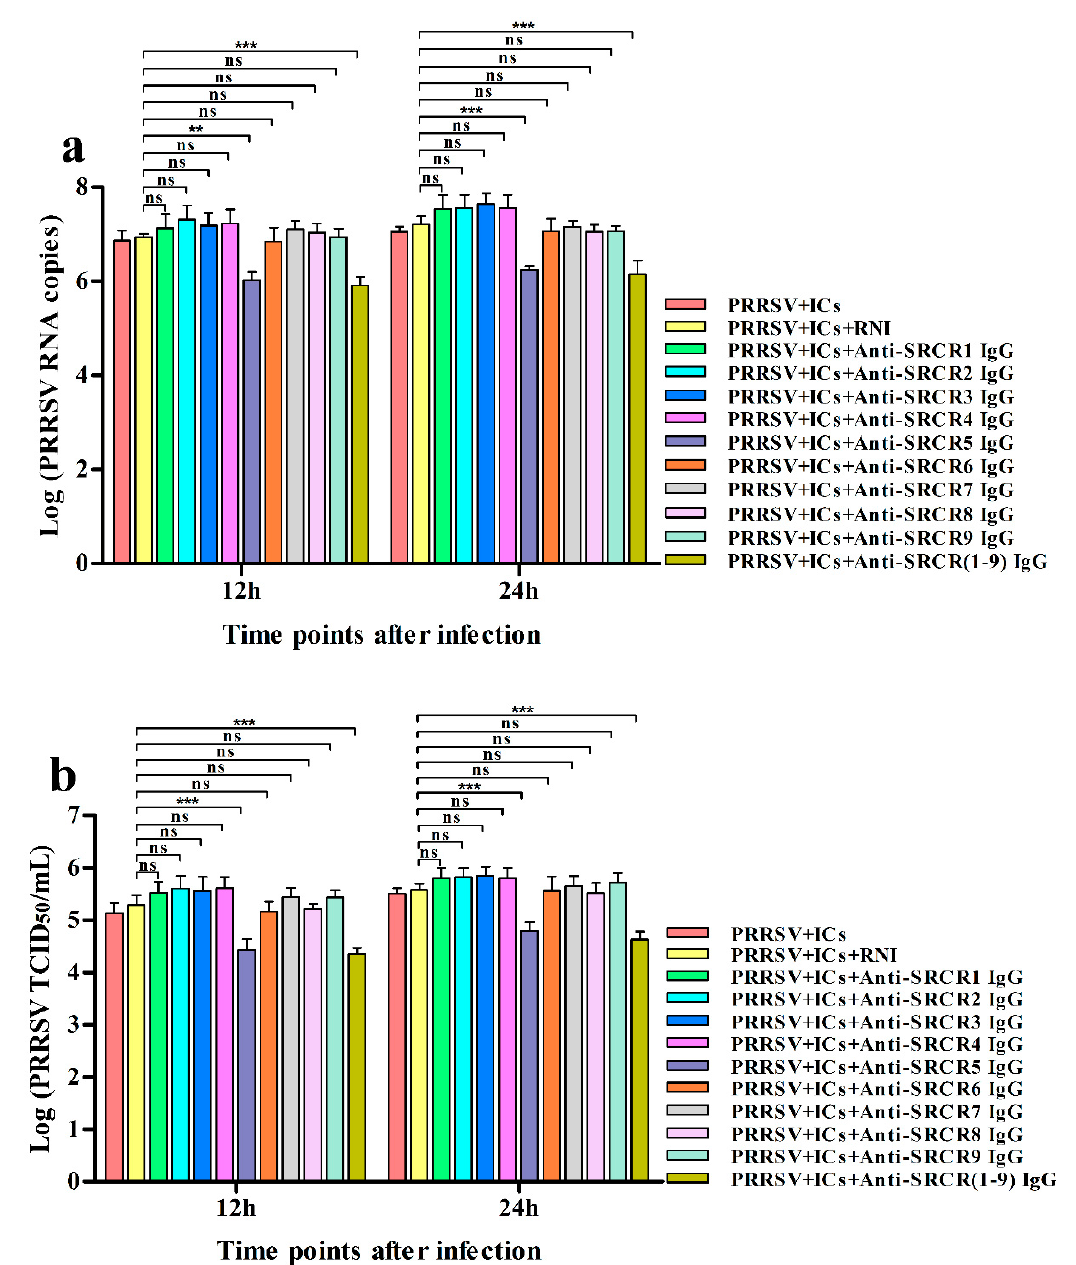
Figure 7. Effect of the antibody blocking of CD163 SRCR domains on PRRSV-ADE activity in PAMs. PAMs cells were pre-blocked by each rabbit anti-SRCR domain IgG or RNI and then infected with PRRSV + ICs. The RNA levels ( a ) and the virus titers ( b ) of PRRSV in cell supernatants harvested were evaluated by real-time RT-PCR and TCID 50 assay. *** p < 0.001, ** p < 0.01, ns: no significance.